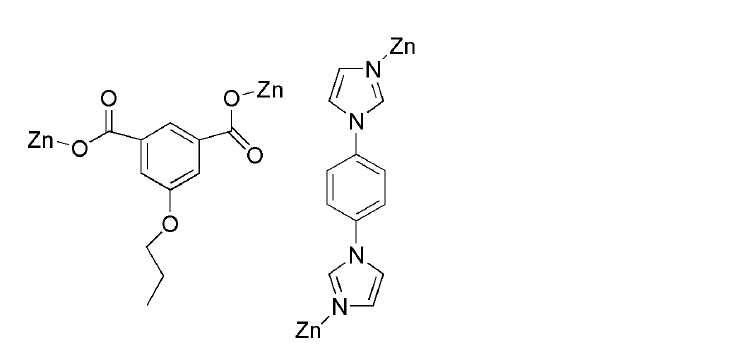
Figure 1. ( a ) The coordination environment of Zn(II) ions in complex 1 . ( b ) View of the 1D zigzag chain of complex 1 . Symmetry codes: i = x + 1/2, − y + 1/2,z + 1/2; ii = − x + 5/2,y − 1/2, − z + 3/2. Color codes: Zn, turquiose; O, red; C, dark green; N, blue. Figure 2. View of the 3D framework of complex 1 parallel to the a -axis.